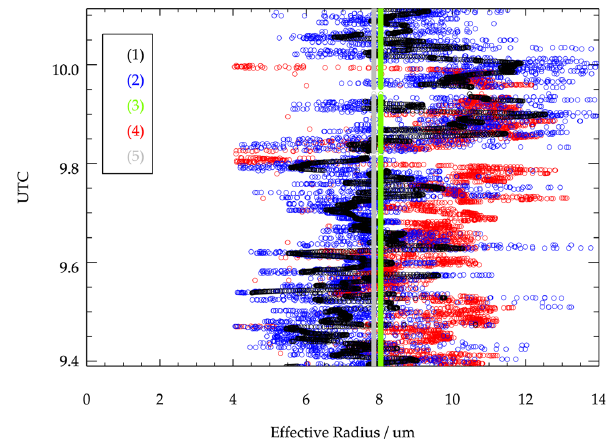
Fig. 9. Time series for the five different choices of the effective radius used as a constraint in the retrieval of the optical thickness from the imaging